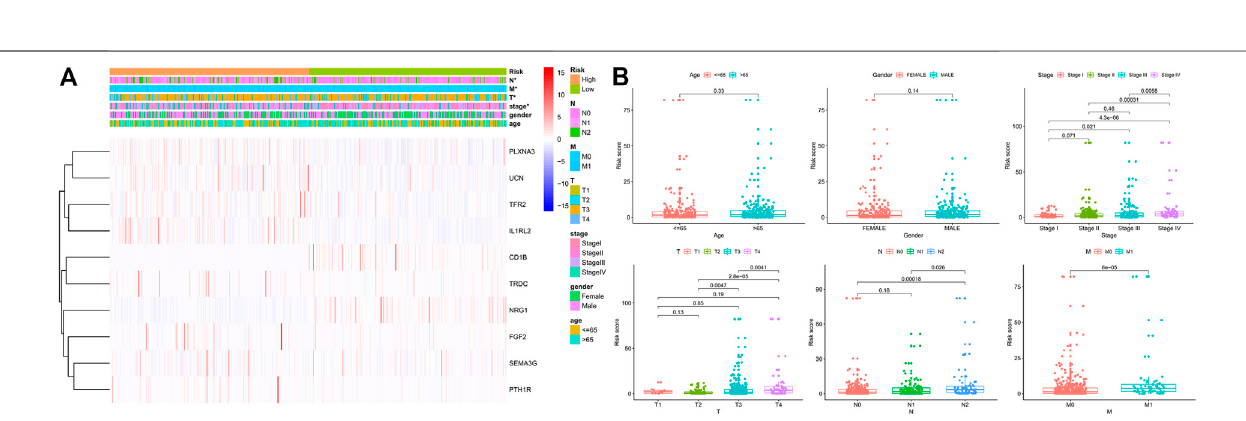
FIGURE 6 | Correlation between the risk score and different clinicopathological parameters. (A) The heatmap shows the distribution of clinicopathological parameters and the expression of the IRGs between the low- and high-risk groups. Chi-square test was used for correlation between clinical and risk. * p < 0.05. (B) Scatter diagram showed that high-risk score levels correlated with advanced pathological